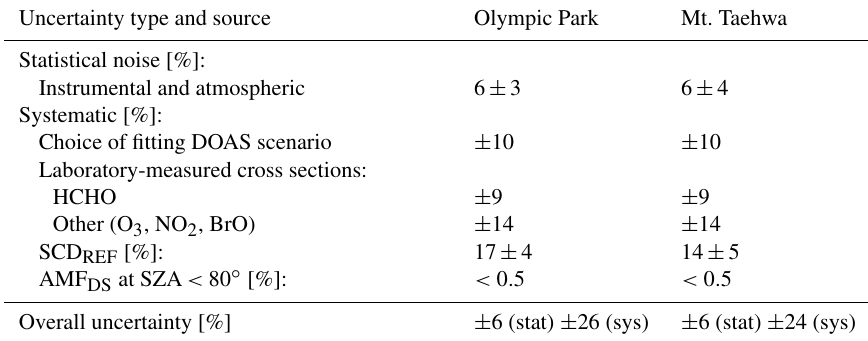
Table 2. Pandora HCHO total column error budget from direct-sun measurements. Uncertainty type and